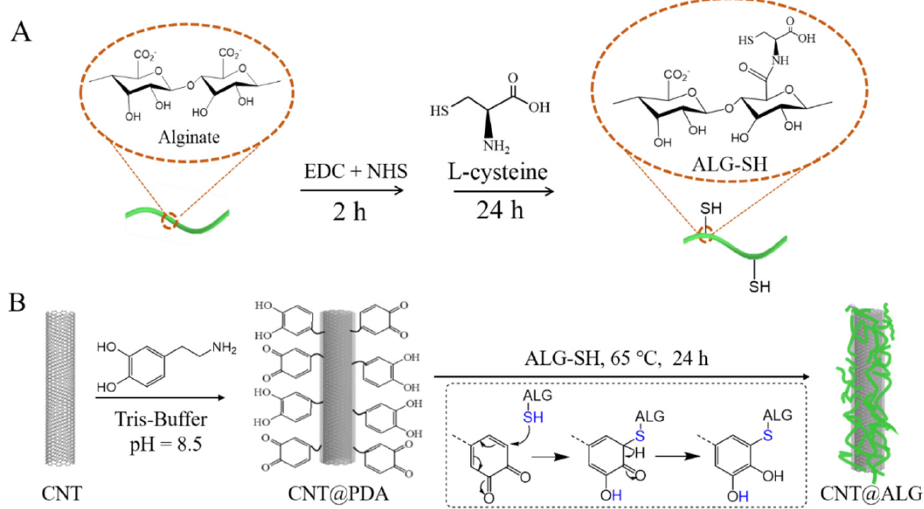
Figure 1. Schematic illustration of the construction of ( A ) ALG − SH and ( B ) CNT@ALG.